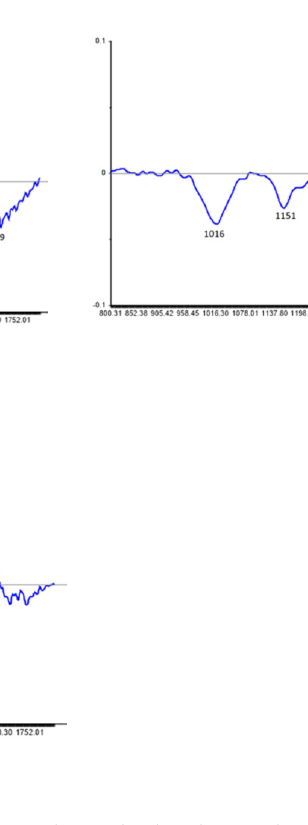
Figure 8. Principal components loadings showing the marker bands considered as the main